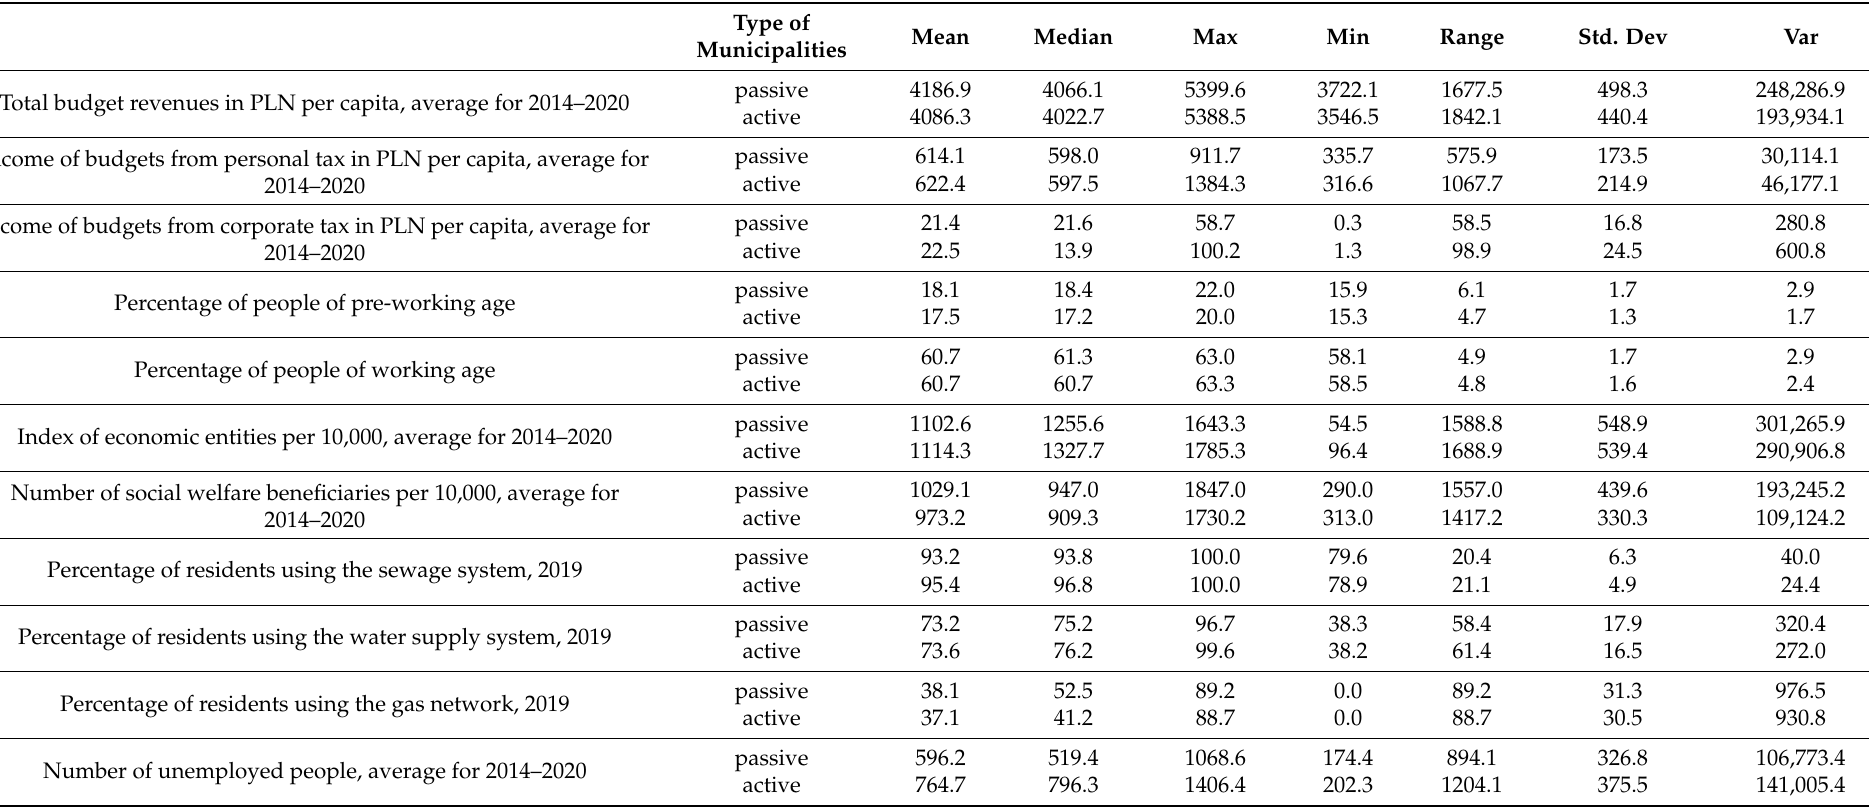
Table 6. Descriptive statistics for selected socio-economic indicators of Cittaslow municipalities passive and active in supporting renewable energy deployment. Type